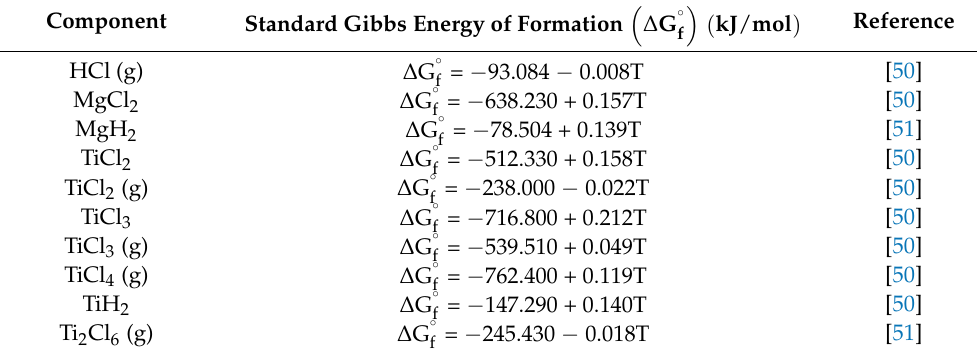
Table 1. Standard Gibbs free energy of formation for the compounds in the investigated system from 0 to 700 ◦